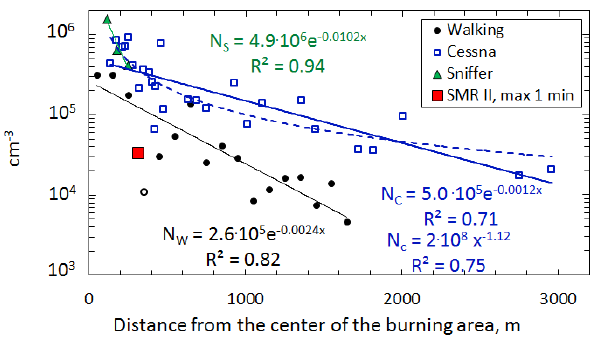
Fig. 15. Particle number concentration as a function of 3- dimensional distance from the center of the burning area measured in the Cessna, with the portable CPCs on the ground (walking, N W ), in the aeroplane (Cessna, N C ), and on the ground in the van ( Snif- fer , N S ). The walking data points are the maximum concentrations of each 100m distance bin, the aircraft data points are the max- ima in each plume crossing and the Sniffer data points the 3–5min average concentrations measured at three standing locations of the van. The SMEAR II data point denotes the maximum 1min particle number concentration in the aerosol cottage during the experiment. The solid lines denote fittings of the exponential function N 0 e − kx and the dashed line the fitting of a power law N 0 x − b , where x is the distance from the center of the burn